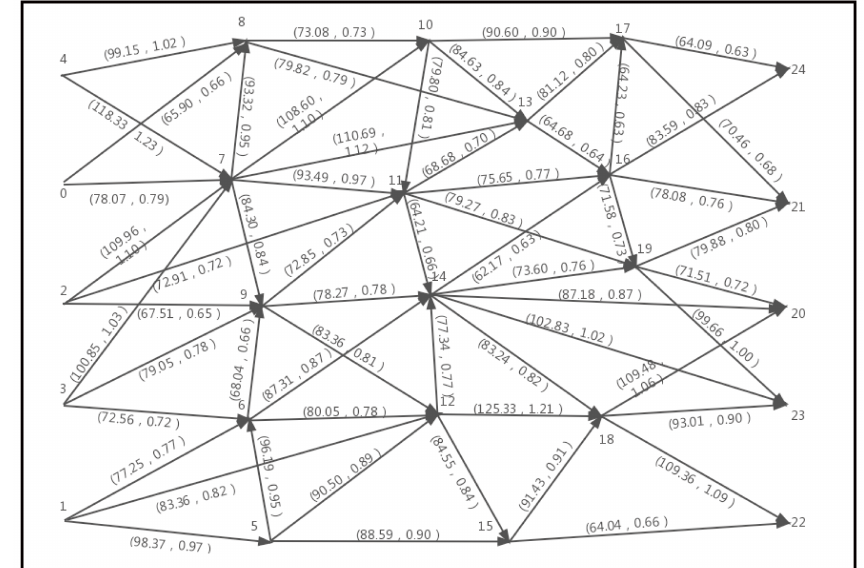
Figure 2. The network of the